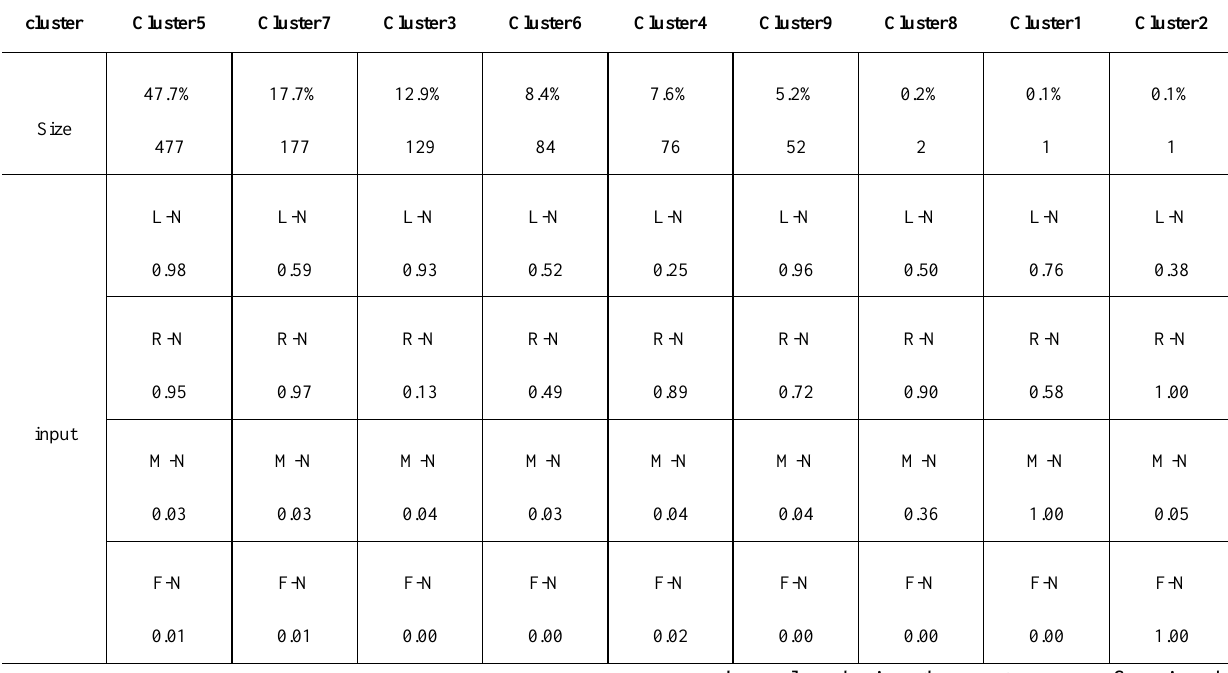
Table 2. Two_Step clustering